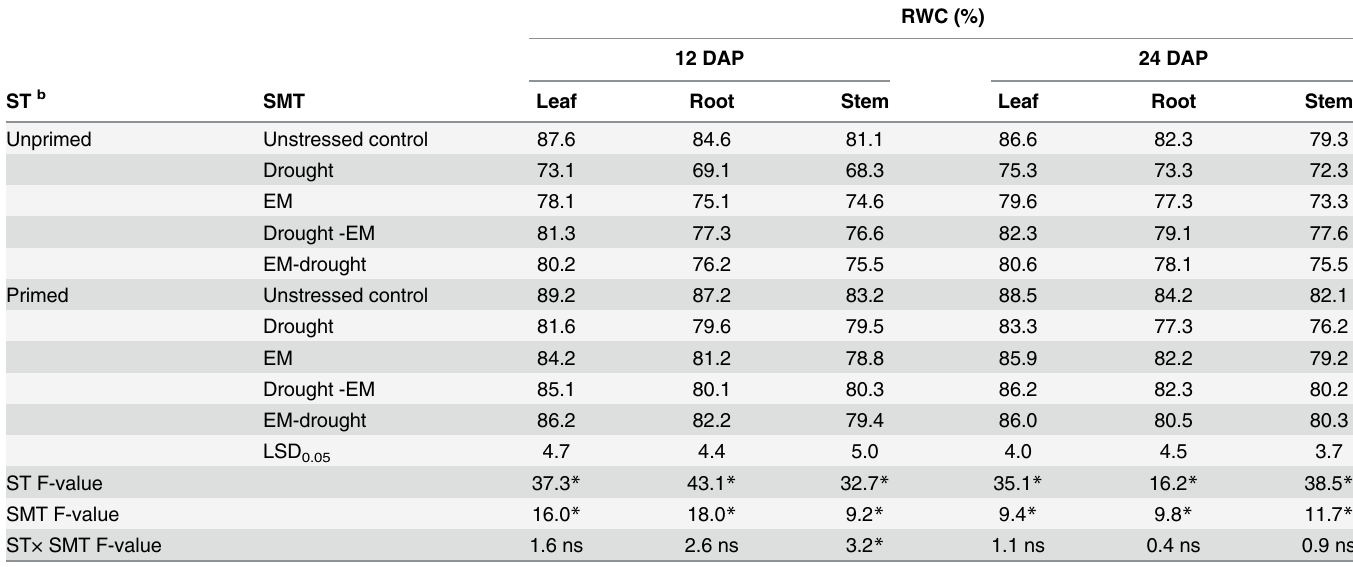
Table 2. Effect of seed priming with PEG and soil moisture stress on leaf, root, and stem RWC in sorghum